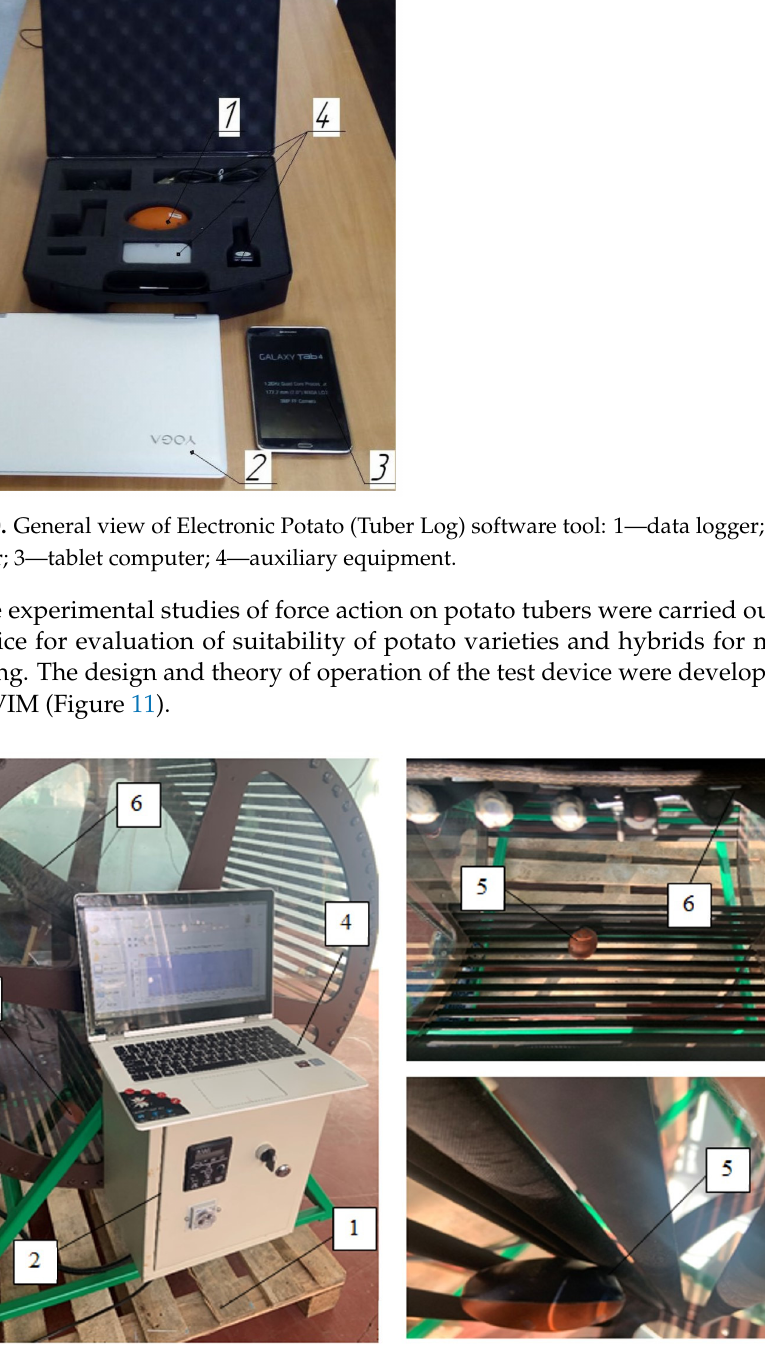
Figure 11. General view of the laboratory setup for studies of force action of the test device for evaluation of suitability of potato varieties and hybrids for mechanized harvesting: 1—support platform; 2—control cabinet; 3—drum; 4—personal computer; 5—data logger; 6—pin hummock